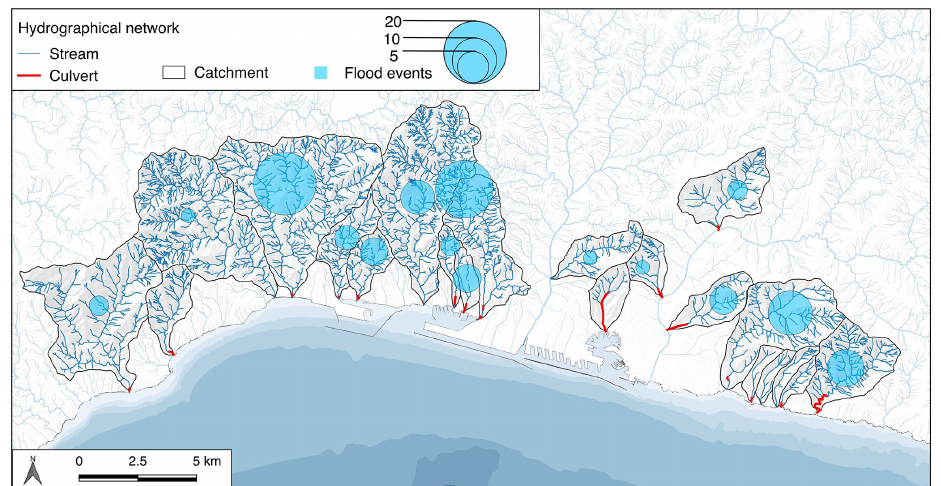
Figure 4. The hydrographical network with the main streams culverted in the last stretch of the studied catchments; the light blue circles are proportional to the number of floods in the catchments in the period of 1900–2016 (Guzzetti, 1994; Luino and Turconi,